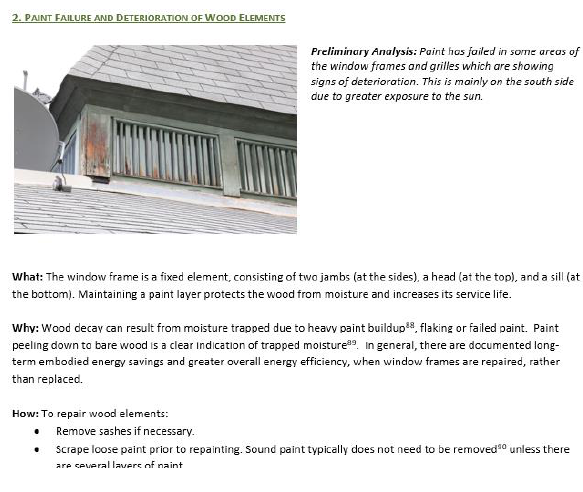
Figure 10. Action for paint failure on clerestory windows